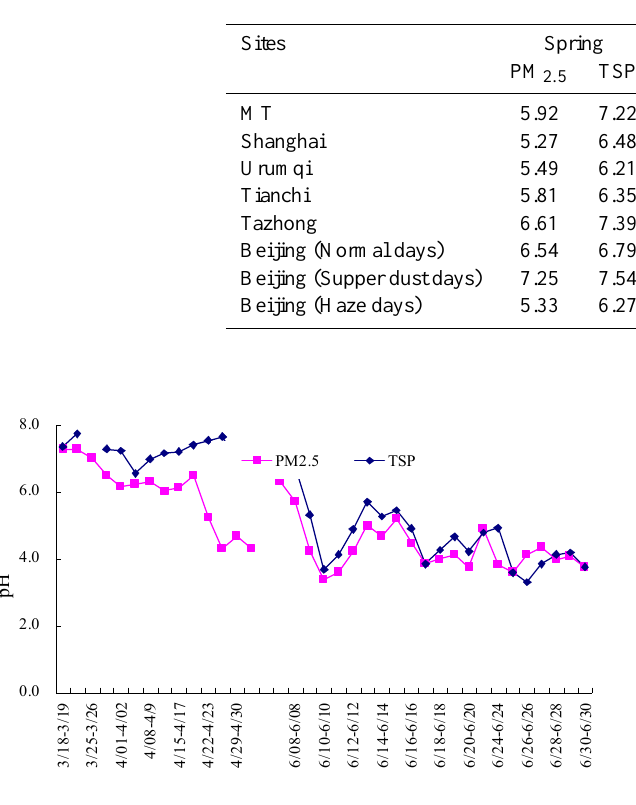
Fig. 6. Concentrations of biomass burning derived K + calculated with two methods in PM 2.5 in 2006 at MT.